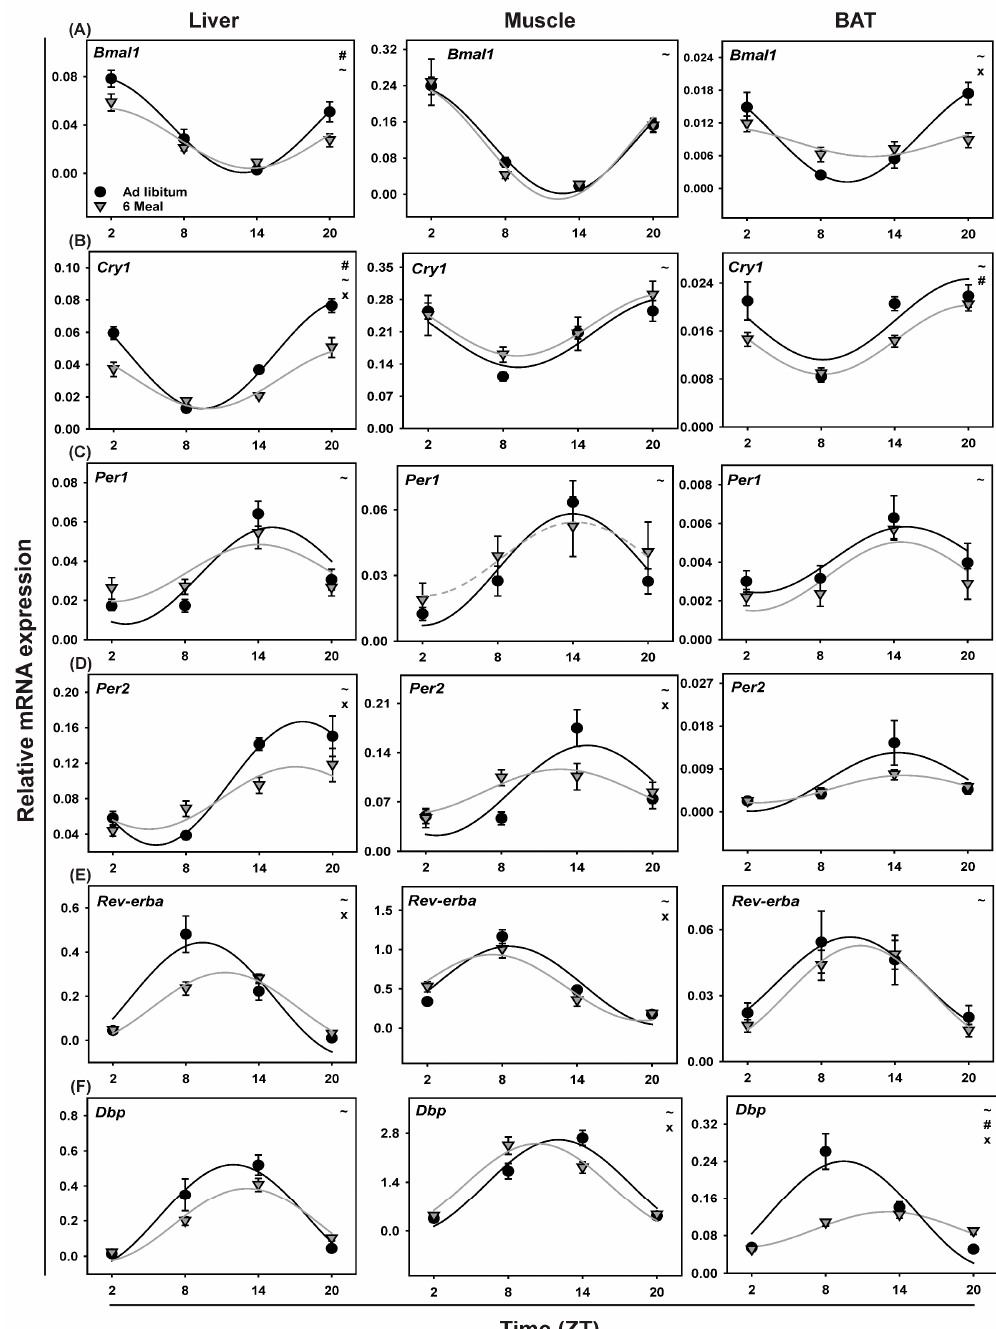
Figure 5. Daily profiles of clock gene expression in Liver, Muscle and BAT in animals fed ad libitum (Black circle) or according the 6 ‐ meals ‐ a ‐ day feeding schedule (Gray triangle). ( A ) Bmal1, ( B ) Cry1, ( C ) Per1, ( D ) Per2, ( E ) Rev ‐ erb α and ( F ) Dbp. Fitted lines show significant cosine regressions (see methods). ~ = Effect of Time ( p < 0.05), # = effect of Feeding ( p < 0.05); × = Interaction effect between Feeding and Time ( p <